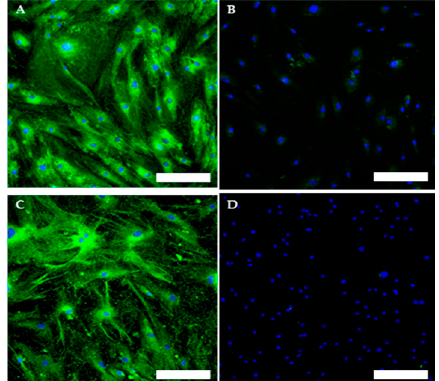
Figure 9. Immunofluorescence staining of neoplastic markers. Immunofluorescence staining of c-Kit ( A ) and of Nestin ( C ) of TOS1-CSC cell line. Immunofluorescence of c-Kit ( B ) and of Nestin ( D ) of human fibroblast cell line (negative control). LSCM in conventional colors: green for c-Kit and Nestin and blue for nuclei. Original magnifications: 10 × . Bar size: 100 µ